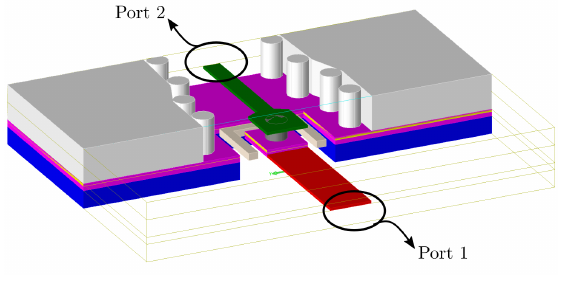
Figure 6. PCB to package